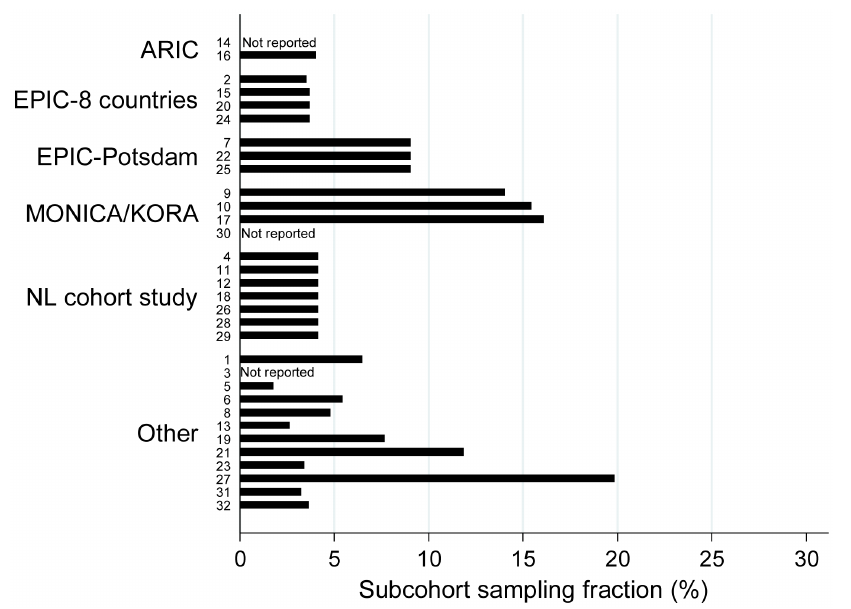
Figure 3. Subcohort sampling fractions reported in each of 32 papers included in the review. Bars are labelled according to the number of the paper in the reference list in Appendix S2.